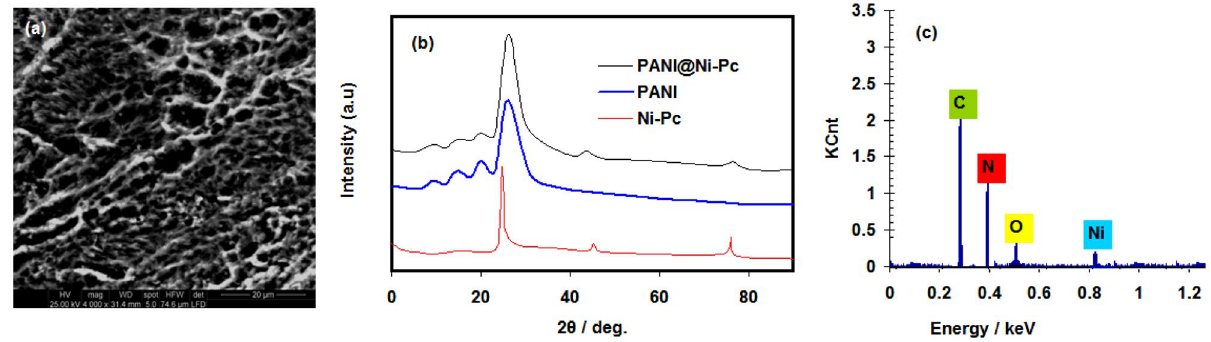
Figure 1. ( a ) SEM image of PANI@Ni-Pc composite, ( b ) XRD pattern of PANI, Ni-Pc and PANI@Ni-Pc composite, and ( c ) EDS pattern of PANI@Ni-Pc